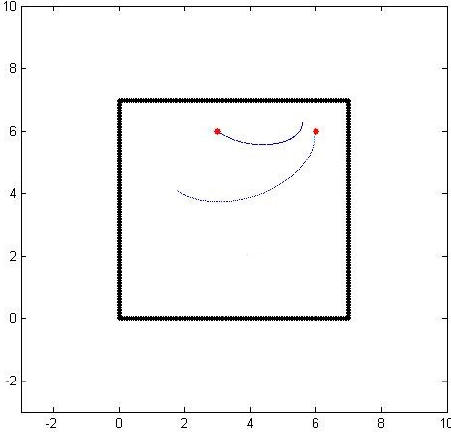
Figure 3. Consistent air-borne particle paths between two sensors.